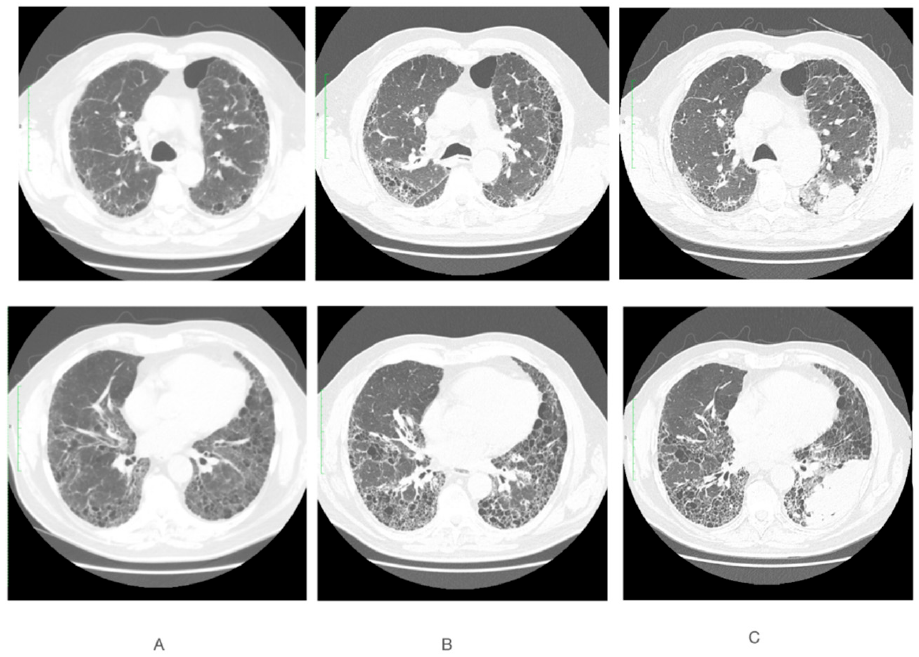
Figure 1. CT scans performed at two depths (upper and lower views) at different time points: ( A ) November 2019, ( B ) March 2021 and ( C ) February 2022. In a chest CT performed in March 2022, polycyclic confluent tissue masses were visualized, infiltrative in the left lung occupying a significant part of the lower lobe and the dorsal parts of the upper lobe with radiological features of the neoplastic lesion. Compared to the CT performed in February, progression of nodal lesions in the mediastinum and hilars was visible (Figure 2A). Nodal changes modeled adjacent structures, including vessels. In addition, significant narrowing of the low lobe artery with the possibility of infiltration, progression of fluid in the left pleural cavity and in the pericardium. In the histopathological examination of the material from endobronchial ultrasound bronchoscopy (EBUS), small cell lung cancer was diagnosed. Immunohistochemical reactions were performed: synaptophysin+, CD56+, Ki67+ in 70% of neoplastic cells. The diagnosis of T4N2M0 small cell lung cancer was confirmed. The presence of an active neoplastic disease is a criterion that excludes participation in the pirfenidone drug program; the patient had to discontinue antifibrotic treatment. Systemic treatment of SCLC was started. Patient was qualified to receive a carboplatin–etoposide regimen, and early treatment tolerance was good. After two cycles of cytotoxic treatment, a partial response was present on theCT (Figure 2B), which was persistent after four cycles (Figure 2C). Cytotoxic treatment was well tolerated, and 4 months PFS was reached. Since the tumor regression was present and there was no longer a risk of bleeding due to central tumor invasion, antifibrotic and antiangiogenic nintedanib treatment was